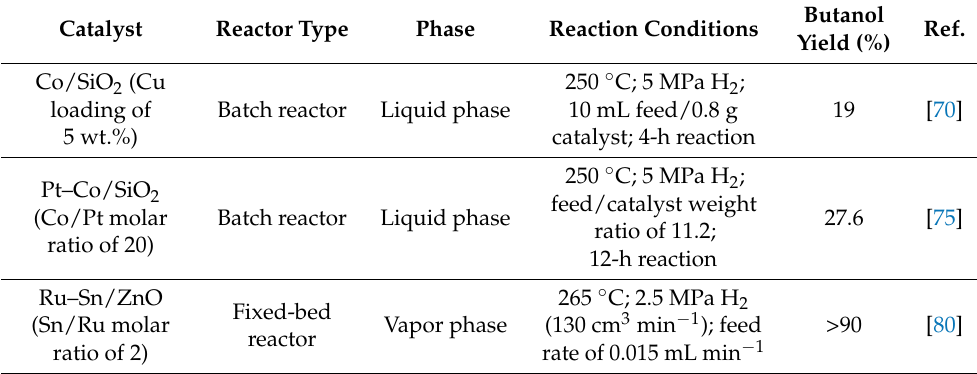
Table 3. Catalysts used for the hydrogenolysis to make n-butanol. All the results are obtained from earlier